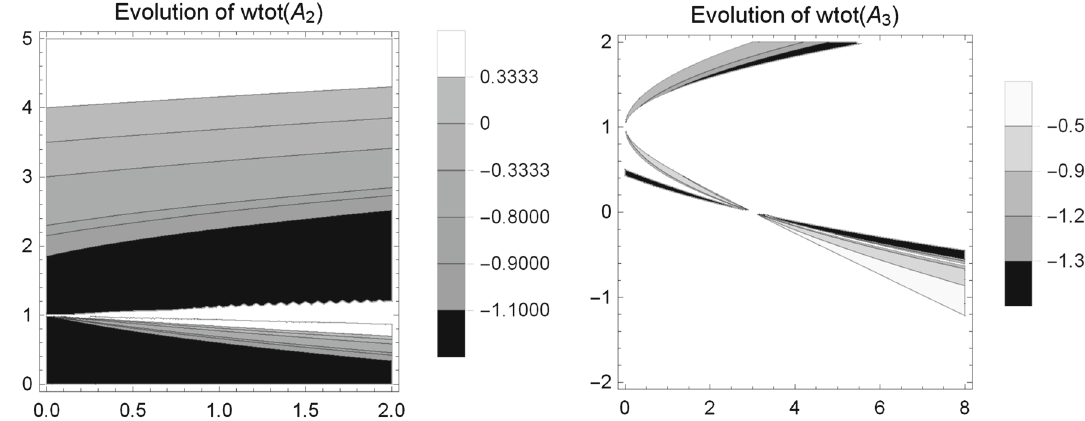
Fig. 8 Qualitative evolution of the equation of state parameter w tot at the equilibrium points A 2 (left graph) and A 3 (right